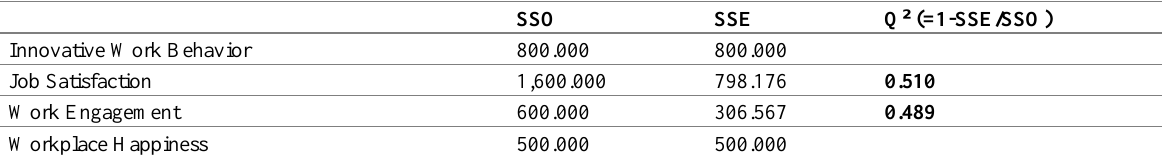
Table 7: Results of Predictive Relevance Test (Q-Square)